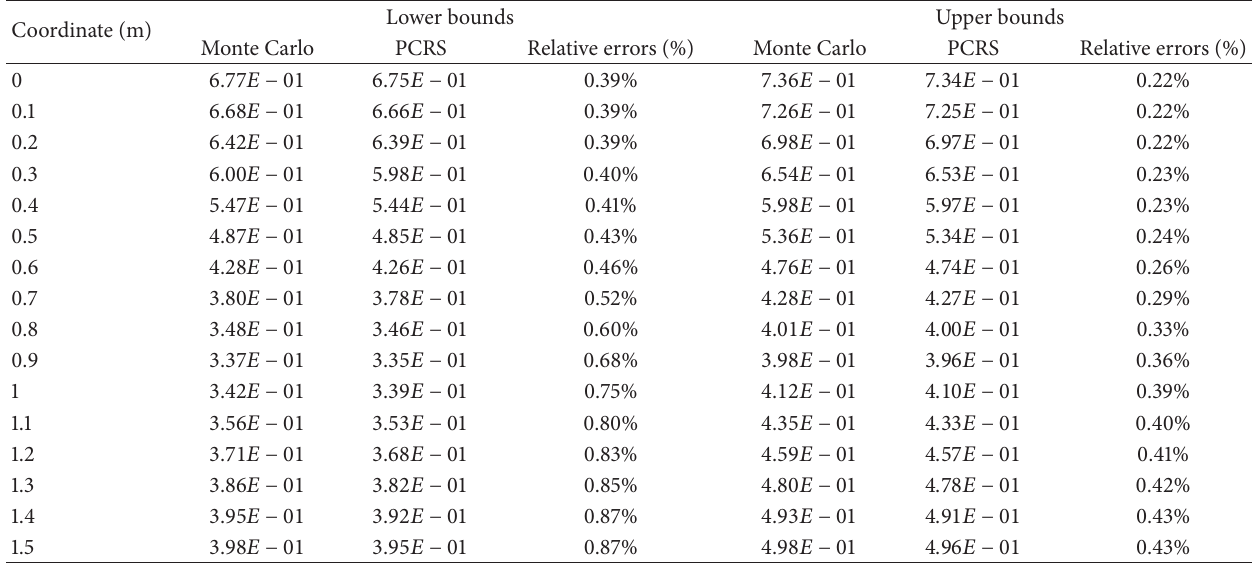
Table 3: The relative errors of the lower and upper bounds of expectation of the frequency response amplitude along the line of 𝑦 = 0.5 m. Coordinate (m)